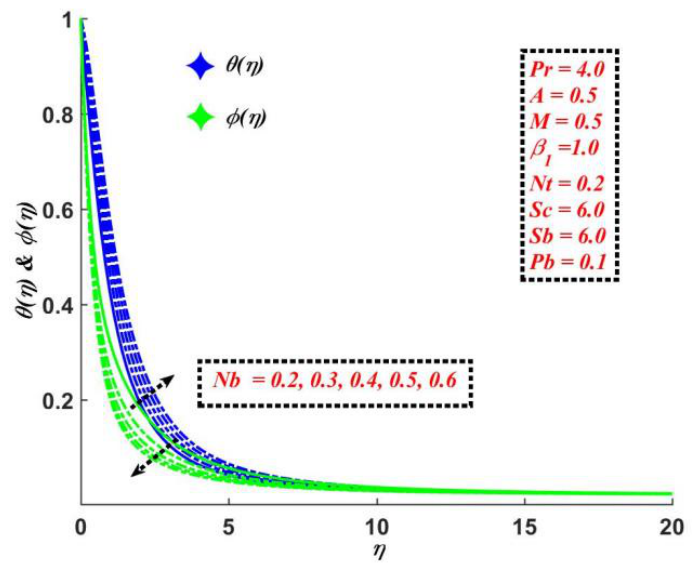
Figure 10. Influence of the Brownian motion parameter on θ ( η ) and φ ( η ) .